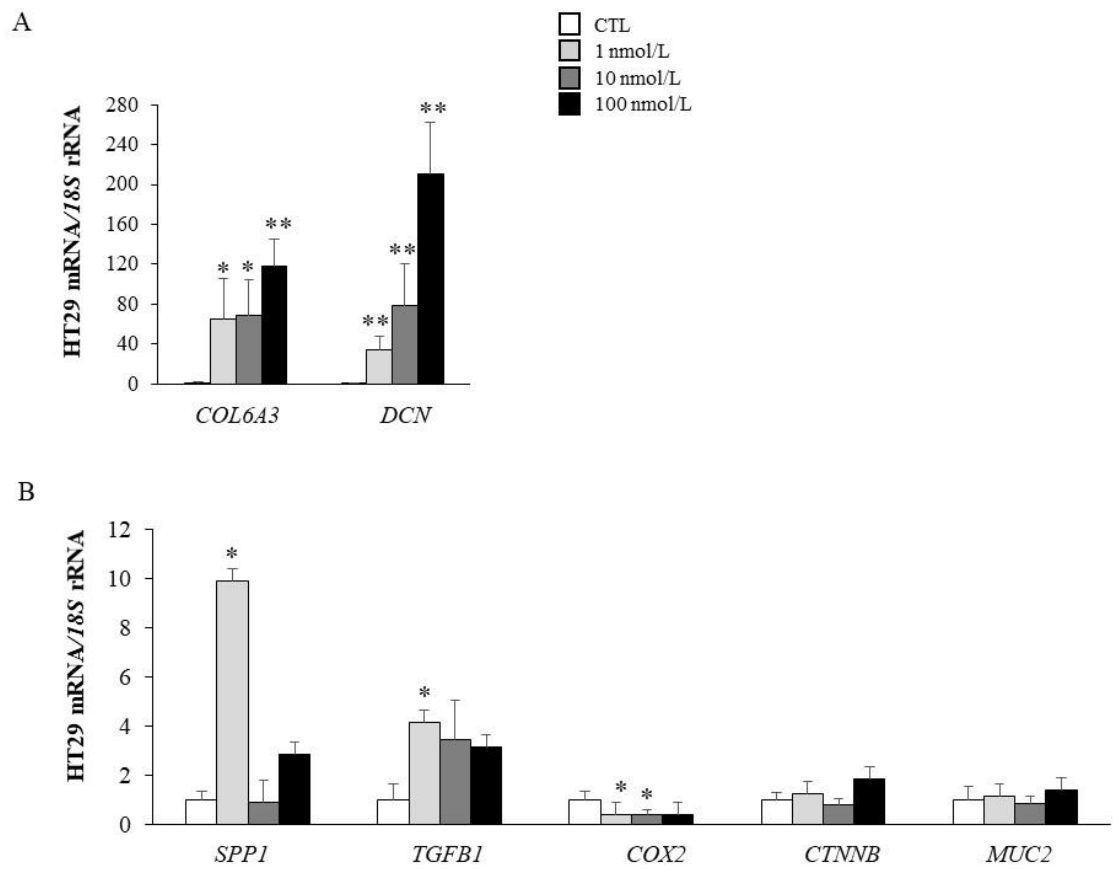
Figure 3. Gene expression levels of extracellular matrix remodelling markers ( A ) as well as tumorigenesis-related molecules ( B ) in HT-29 cells stimulated with different concentrations of recombinant MAGP-1 for 24 h. Gene expression levels in unstimulated cells were assumed to be 1. Values are the mean ± SEM ( n = 6 per group). Differences between groups were analyzed by one- way ANOVA followed by Dunnett’s post-hoc tests. * p < 0.05 and ** p < 0.01 vs. unstimulated cells.